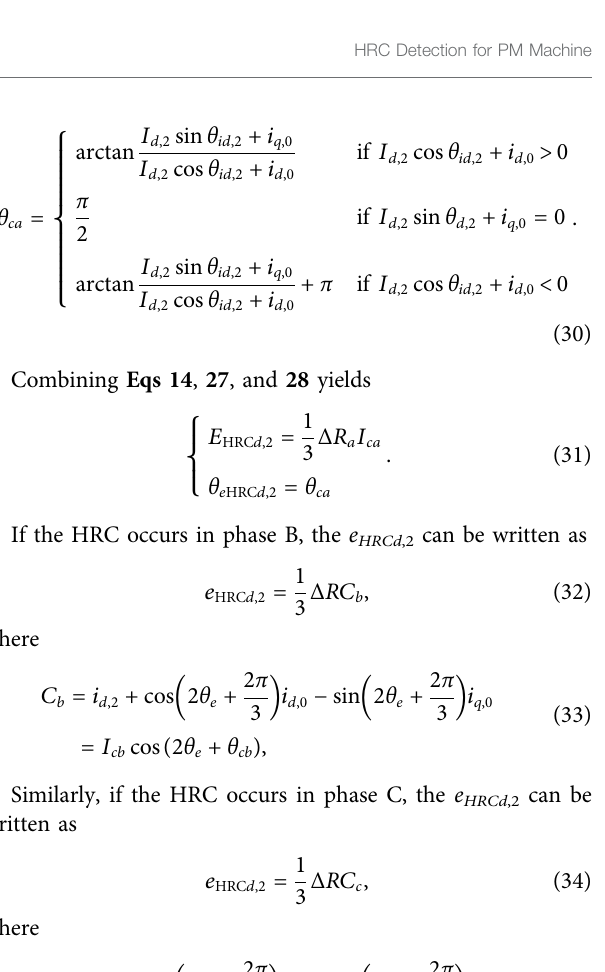
FIGURE 12 | Waveforms of the PM machine with HRC ( Δ R = 0.5 Ω ) occur in phase C.